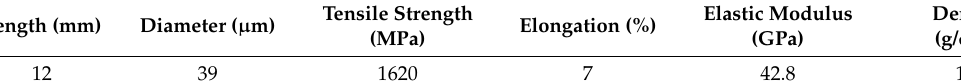
Figure 2. Specimen details (units: mm).